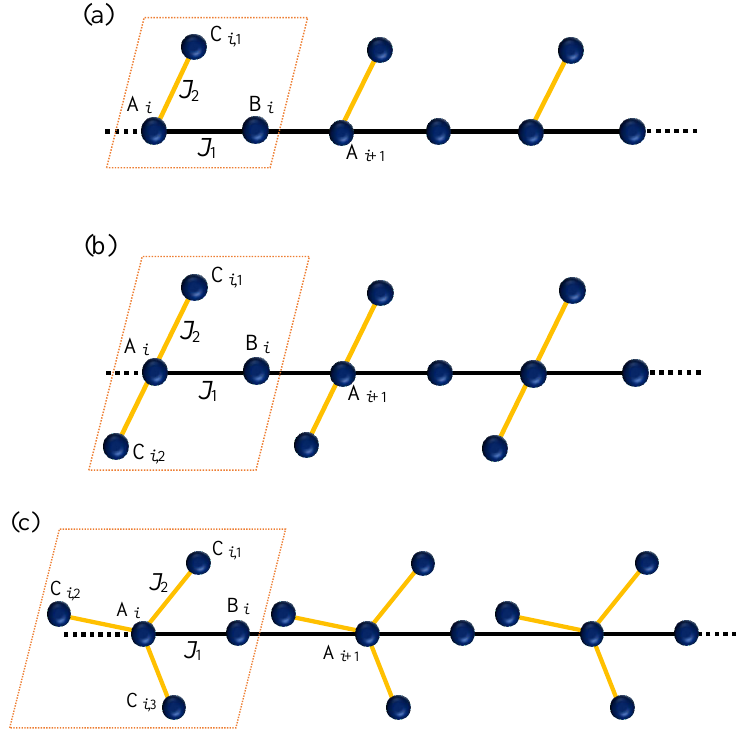
Figure 1. Schematic structure of the spin-1/2 XXX Heisenberg model on the branched chains ( a ) Υ 1 with one, ( b ) Υ 2 with two, and ( c ) Υ 3 with three intra-chain interactions J 2 . J 1 denotes inter-chain interaction. In each case, the dotted rectangle indicates a unit cell that uniformly repeats throughout the chains. Solid balls labeled as A, B, and C represent spin-1/2 particles in a unit block, and the balls marked with C i indicate the side